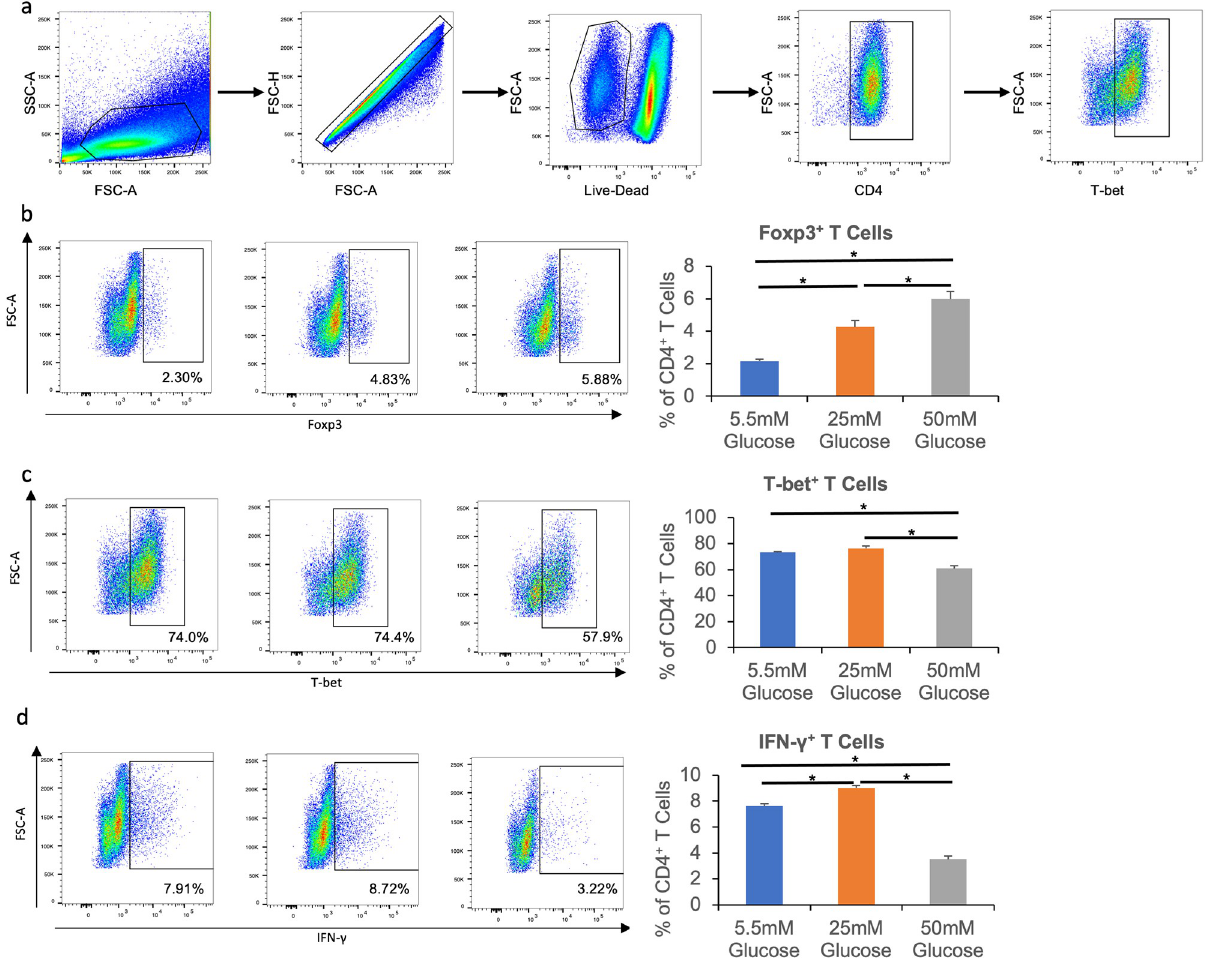
Fig 3. High glucose promotes Treg and inhibits Th1 differentiation under mixed cytokine conditions. Na ï ve CD4 + T cells were isolated from C57BL/6 mice and cultured in 96-well plates with plate-bound anti-CD3, and soluble anti-CD28, IL-12, and latent TGF- β for 72 hours. Cells were then stimulated with Cell Stimulation Cocktail for 4 hours before staining with fluorescence-conjugated antibodies and analyzed with flow cytometry. a , Representative flow cytometry gating for T cell populations. b , Percentages of CD4 + Foxp3 + T cells in all CD4 + cells. c , Percentages of CD4 + T-bet + T cells in all CD4 + cells. d , Percentages of CD4 + IFN- γ + T cells in all CD4 + cells. N = 3, and data are presented means ± S.E.M. � p < 0.05 by Student’s t